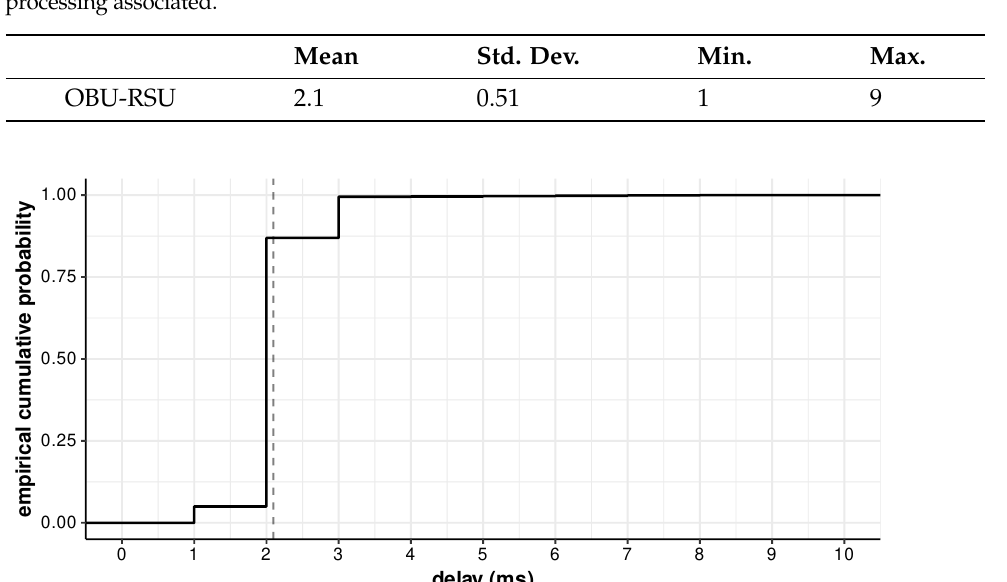
Figure 12. Empirical CDF representation of the OBU (Access layer) to RSU (Access layer) message delay. Sample size of 10,000 CAMs. The average values is indicated through the vertical line (2.1 ms).